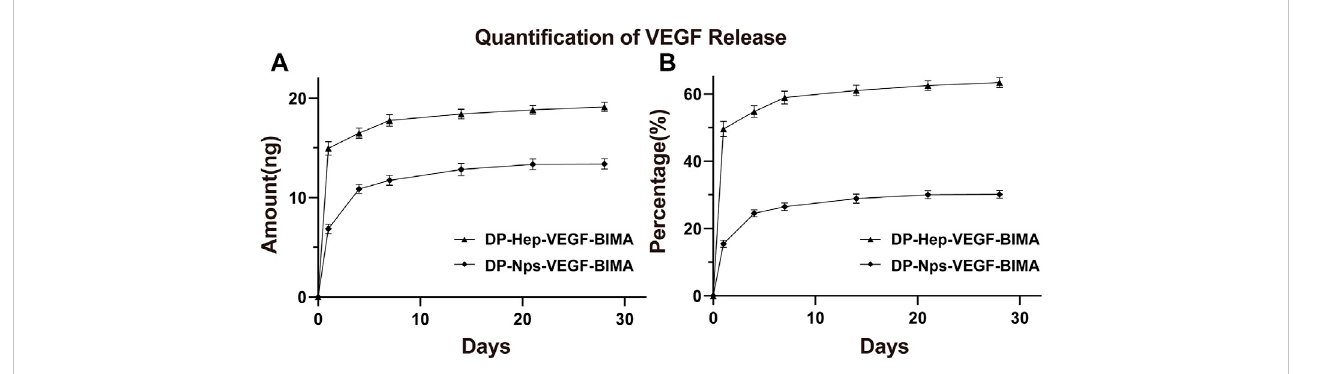
FIGURE 4 Quanti fi cation of VEGF release in amounts (A) and in release percentage (B) , n = 3.